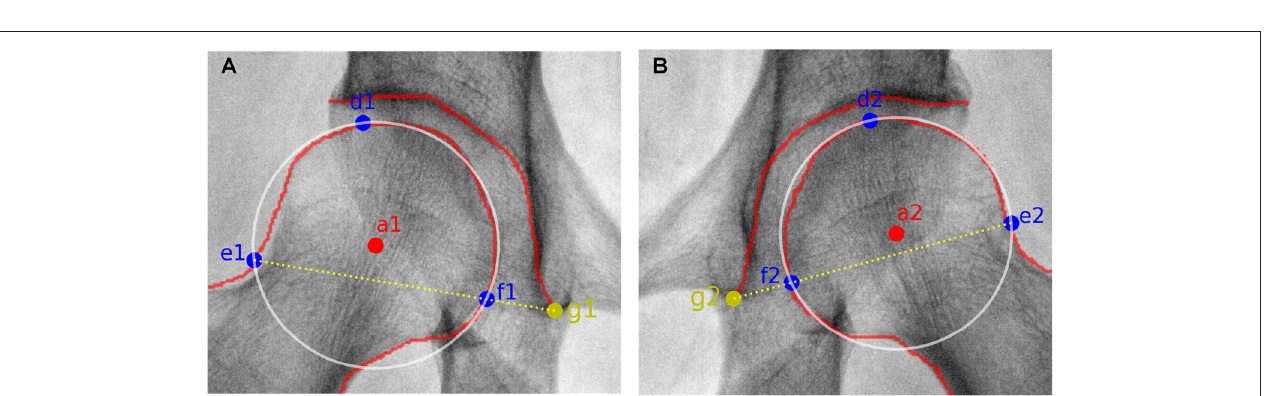
FIGURE 2 | Sketch maps of feature angles. (A–D) correspond to CE, sharp, Tonnis, and caput collum diaphysis (CCD) angle, respectively. Considering that CCD only measures coxa valga or coxa vara on femoral head, it is discarded in the following study.